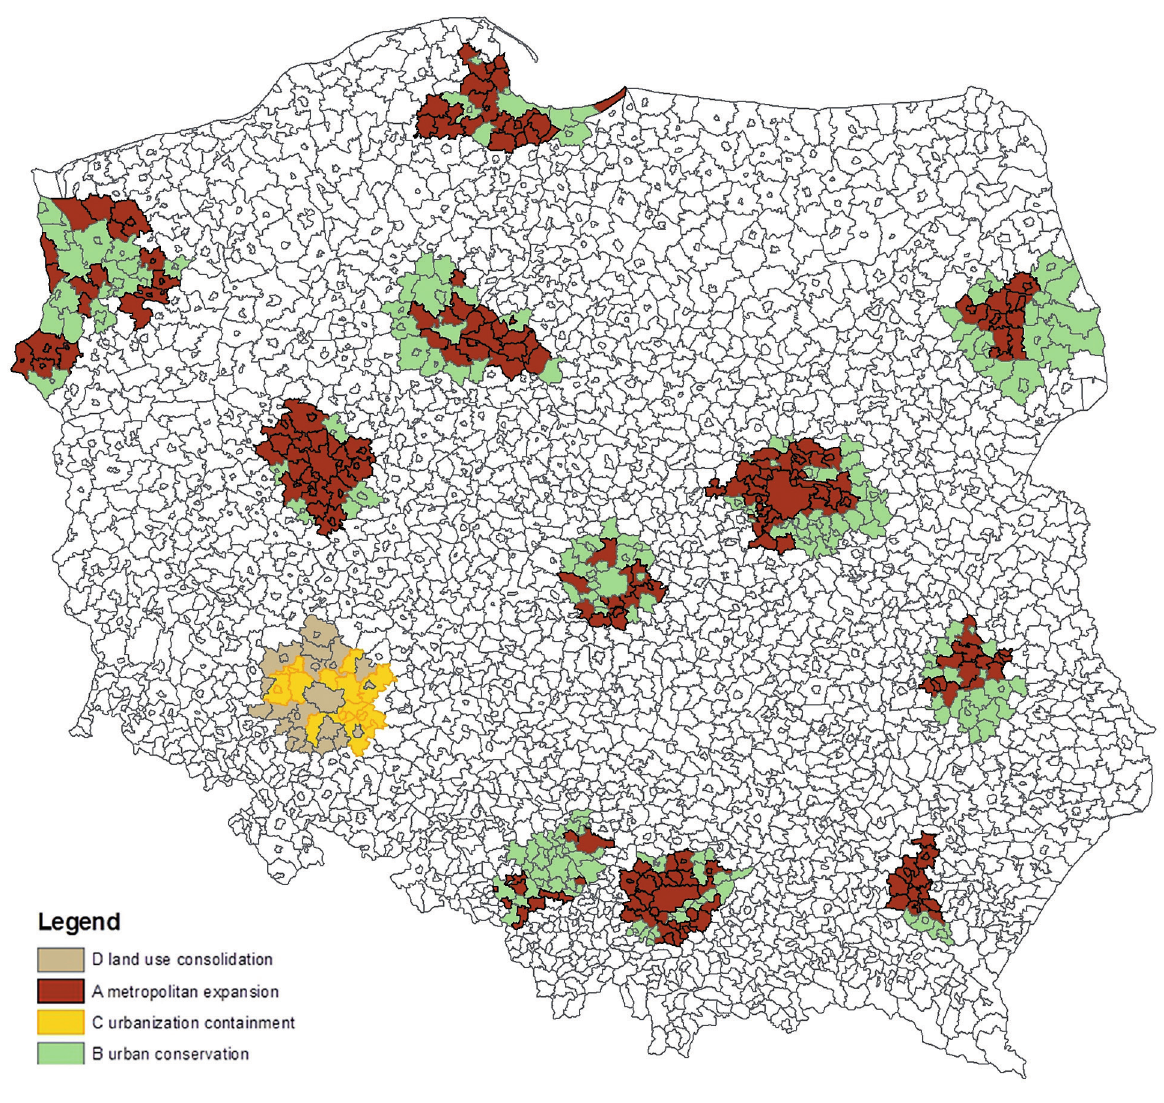
Fig. 7. Spatial interactions vs. land use changes in the metropolitan areas of Poland (quotients of population potentials vs. quotients of entropy values),